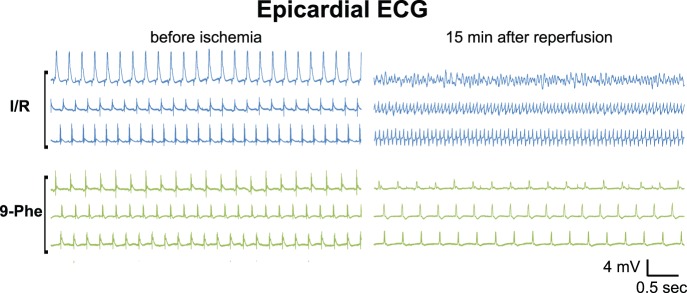
Representative epicardial ECGs from Langendorff excised hearts.Three representative recordings are shown for the control and 9-Phe-treated groups. While ventricular fibrillation or tachycardia was evident at 15 min after ischemia–reperfusion in the control group, regular rhythm was maintained in the 9-Phe-treated group.